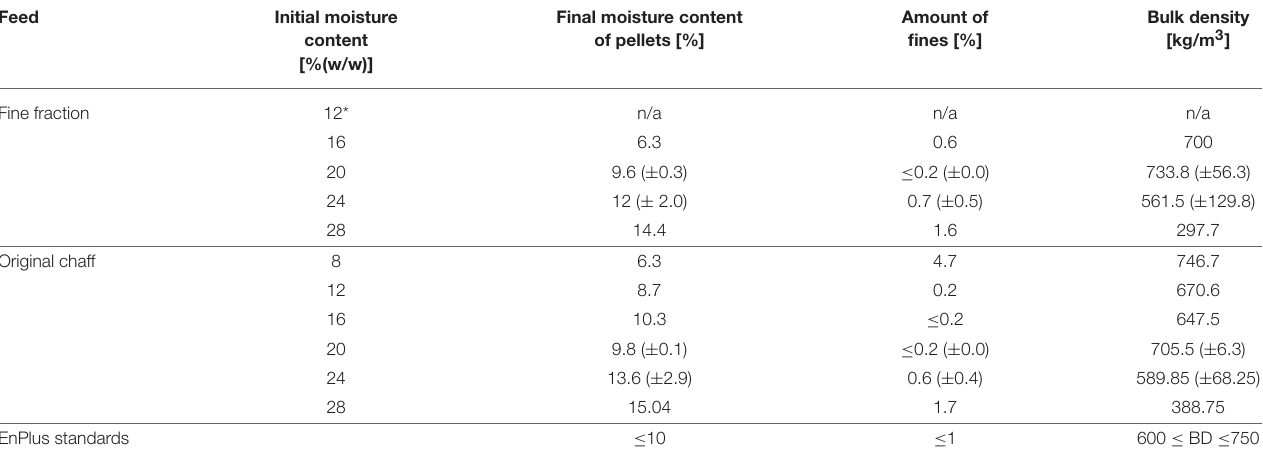
TABLE 4 | Characteristics of produced pellets from feedstocks with different initial moisture contents (l/d = 5).